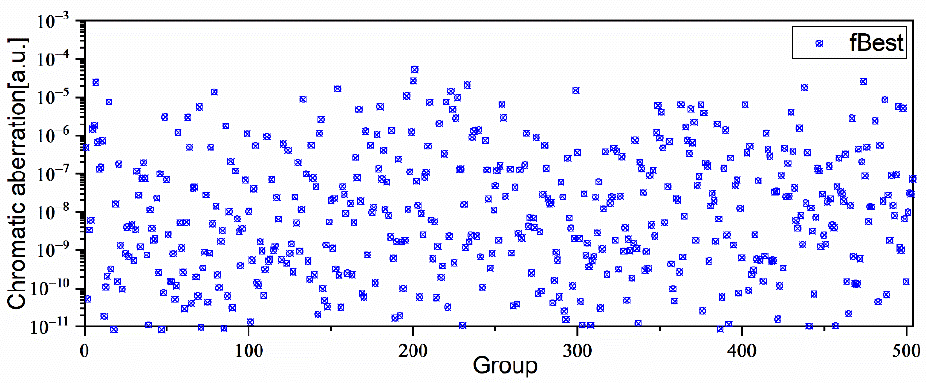
Figure 5. Search results of APSO algorithm for four-reflection system; ( a ) the parameter search results of the objective function; ( b ) the optimization results of objective function value of APSO algorithm; ( c ) the optimization results of objective function variance value of APSO algorithm.